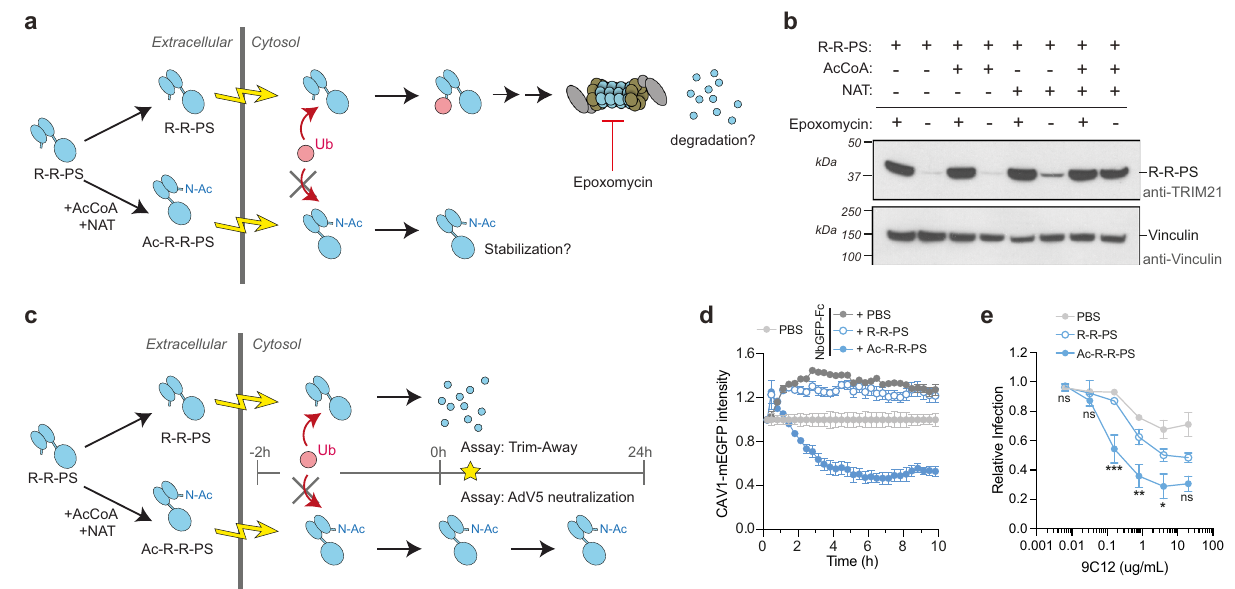
Fig.3|N-terminalubiquitinationregulatesligaseturnoverincells.a Schematic showing electroporation of R-R-PS±N-terminal acetylation and proteasome- dependent degradation. b Western blot of experiment depicted in ( a ) 1h post- electroporation.R-R-PSproteinlevelsarerescuedbyadditionof10 µ Mproteasome inhibitor epoxomycin. Ac-R-R-PS protein persists in cells irrespective of protea- some inhibition. Representative example from n =2 independent experiments. c SchematicshowingelectroporationofR-R-PS±acetylationintocells,followedby delayed Trim-Away or Adv5 neutralization assays. d For the delayed Trim-Away assay, mRNA encoding the antibody construct (NbGFP-Fc) responsible for recruiting R-R-PS to substrate (CAV1-mEGFP) was co-electroporated into NIH3T3 CAV1-mEGFP cells with PBS or R-R-PS±acetylation; Trim-away is delayed for ~2h until NbGFP-Fc protein is translated. Graph shows mean and s.e.m. from n =4